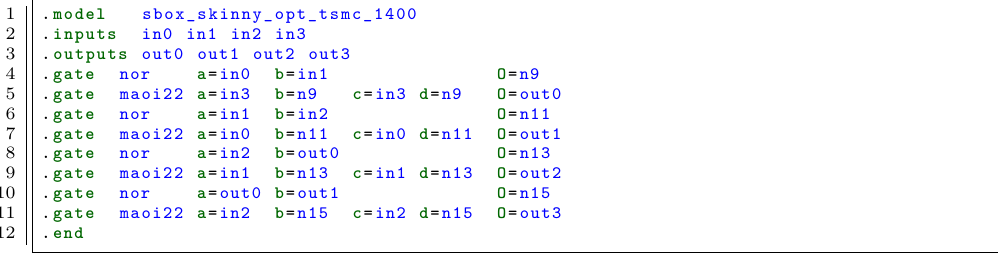
Figure 11: Area-optimized hardware implementation of SKINNY Sbox using 14.00 GE with the standard cell library of the TSMC 65nm logic process.